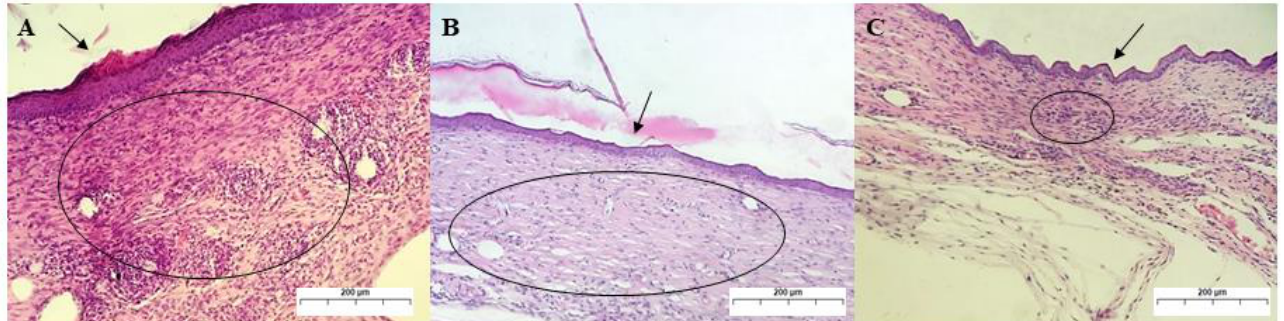
Figure 12. Photomicrograph of skin lesion in mice on the 21st day of treatment. ( A ): Re-epithelization and keratinization (arrow) of a wound treated with PS, with granulation tissue in the dermis (circle) still showing great cellularity and collagen deposition at the dermo-epidermal junction. ( B ): Thin layer of epidermal re-epithelization and keratinization (arrow) in the treatment with GChi, with granulation tissue in the mature dermis (circle) and few fibroblasts. ( C ): Re-epithelization and keratinization of the epidermis in the treatment with GChiN2, showing retraction of the wound, with avascular scar (circle) containing many spindle fibroblasts (magnification: 100 × ). Staining by H.E. physiological serum (PS), chicha hydrogel (GChi), chicha hydrogel with 0.02 g mL − 1 nerolidol